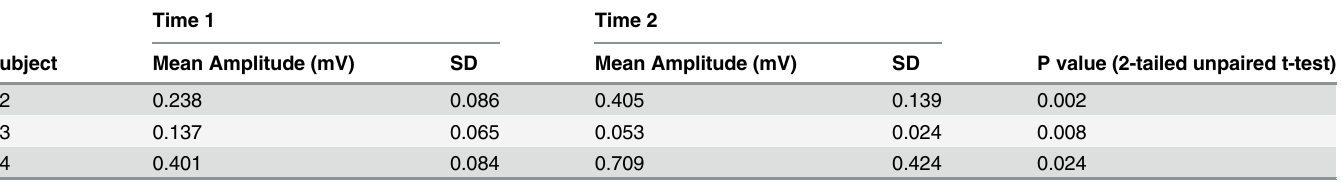
Table 2. Intra-individual variation in motor evoked potential amplitudes in people with AHC. Time